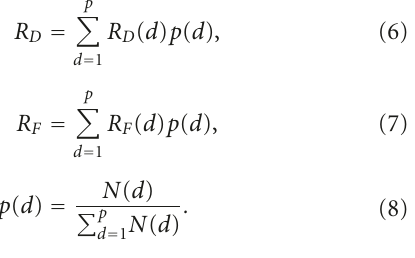
necessary to add Gaussian noise in the simulated brain MRIs.